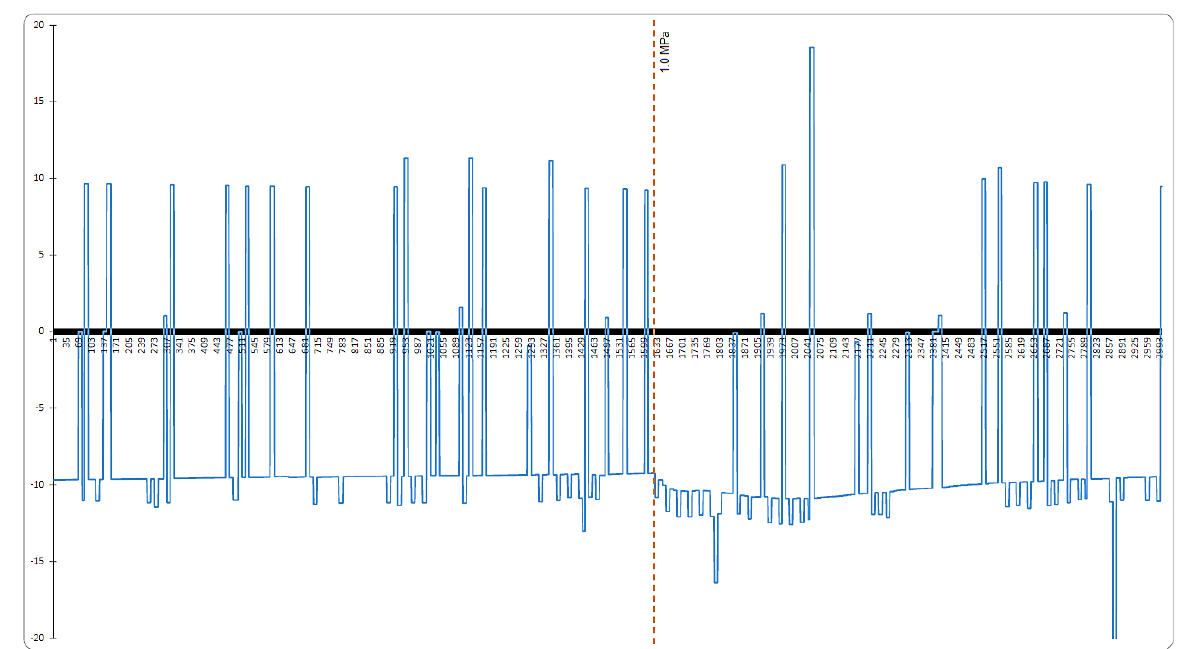
Figure 16. Characteristic of the output signal at a stress in the soil of 0–1.0 MPa. The potential jump with the total stress in the soil σ = 1.0 MPa and the incremented stress Δ σ = 0.25 MPa was Δ U = 3.2022 mV (see Figure 17).